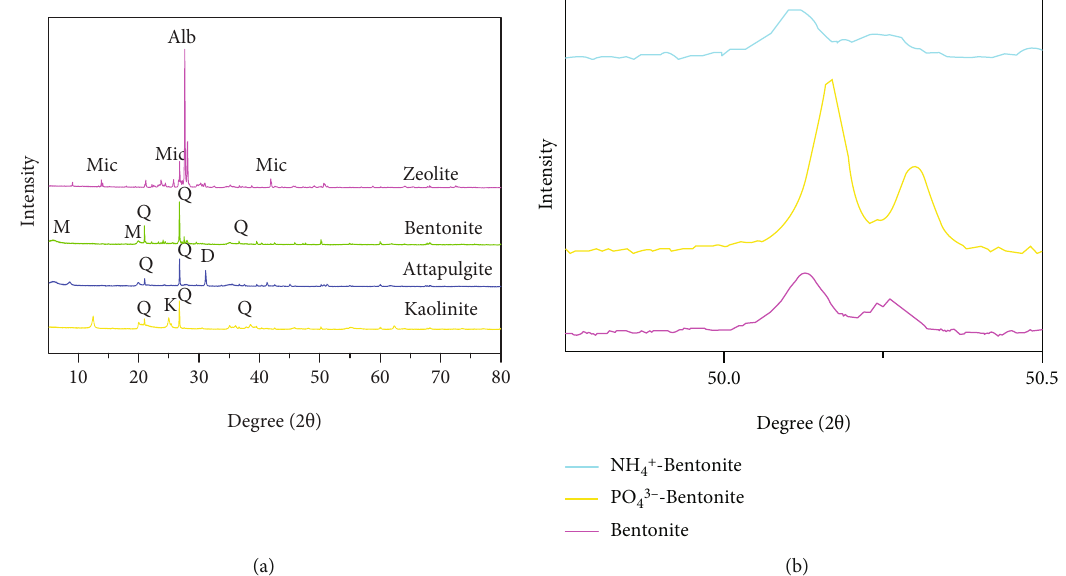
Figure 1: XRD patterns of four NCMs (a) and bentonite after adsorption of ammonia nitrogen and phosphate (b). Q =quartz; K=kaolinite; D=dolomite; Alb =albite; Mic=microcline; M